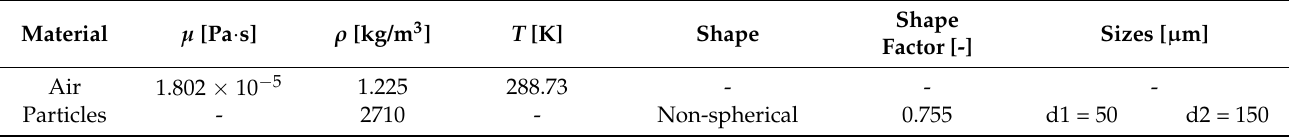
Table 1. Dimensions pipeline validation cases.